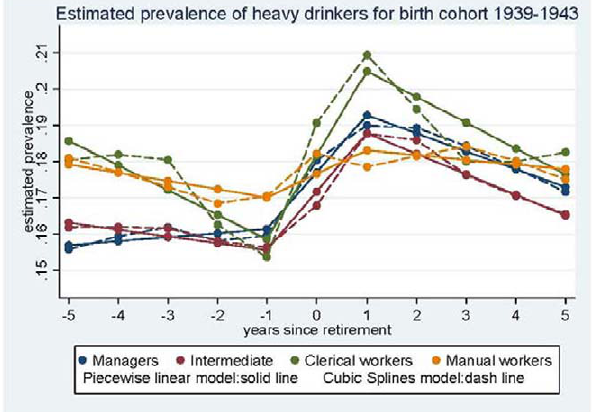
Figure 2. Estimated prevalence of heavy drinkers - Men.